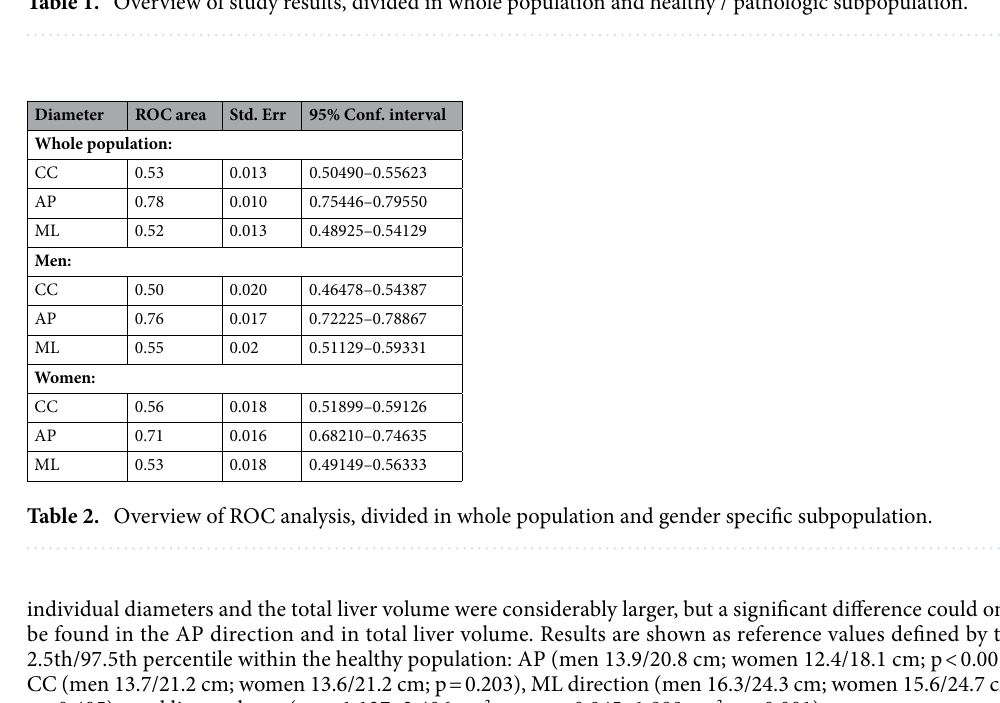
Table 1. Overview of study results, divided in whole population and healthy / pathologic subpopulation.